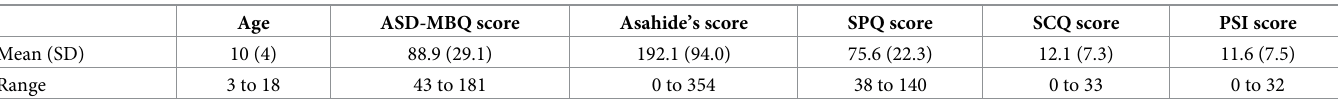
Table 2. Participant characteristics.